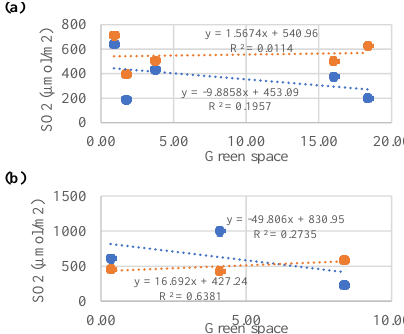
Figure 12. Influence of green space on SO 2